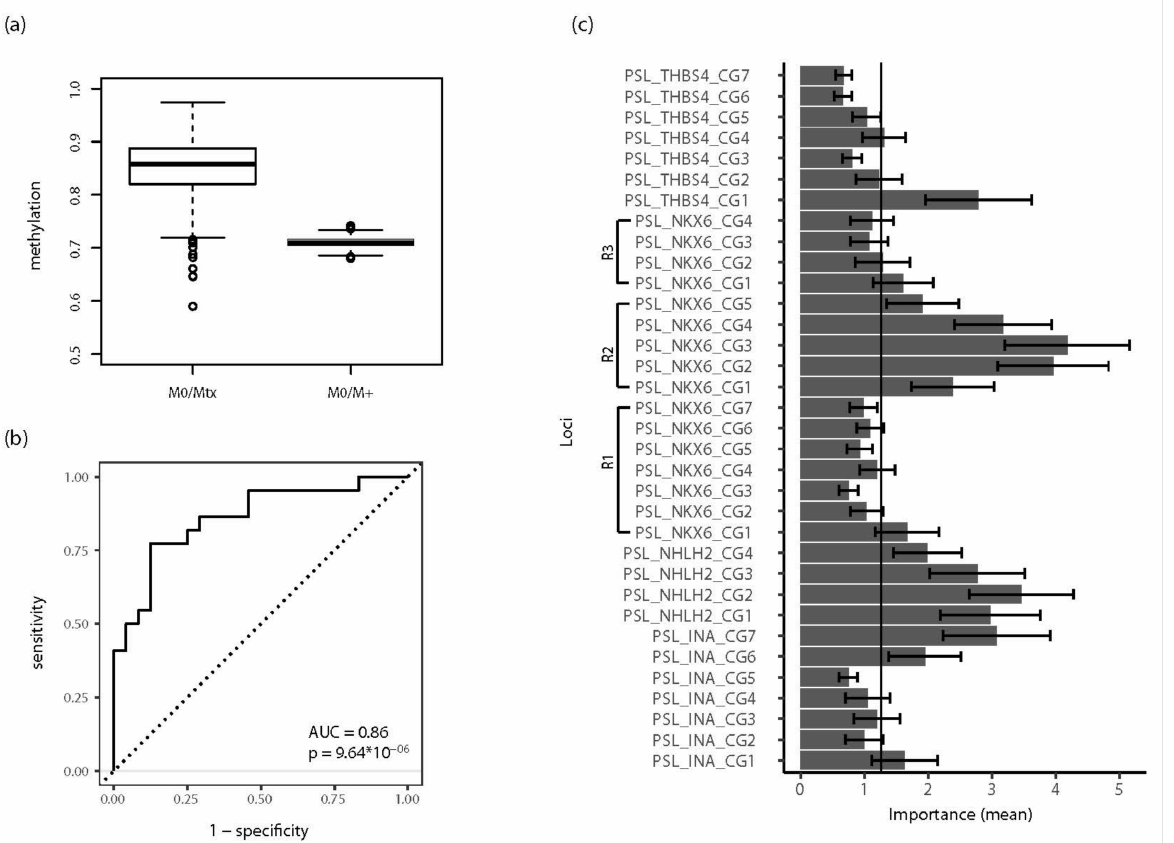
Figure 6. Renal metastasis associated methylation signature (RMAMS) and detection of metastatic primary cancer. ( a ) Box plot analysis of the distributions of ROC-AUC values following 1000 random splits of training and test cohorts and random forest classification analysis for detection of metastatic tissues. ( b ) Exemplary ROC analysis for RMAMS detection of metastatic tissues exhibiting median ROC-AUC of random runs shown in ( a ). ( c ) Bar plot of variables of importance analyses of the random forest classification for the detection of metastatic tissues following 1000 random splits into training and test cohorts. Data are presented as mean and standard deviation (error bars). The vertical line shows the median